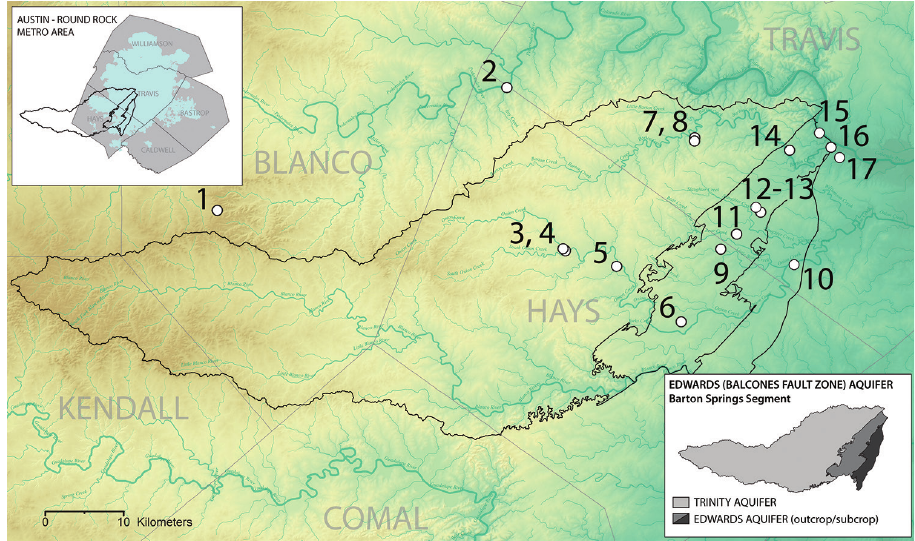
Figure 1. Sample Sites. Sampling map showing the extent of the Barton Springs Segment of the Edwards (Balcones Fault Zone) Aquifer and its hydrozones in Hays, Travis, and Blanco counties, Texas, USA. Sampling sites are numbered as follows: 1 Bamberger Ranch Spring 2 Red’s Spring 3 Emerald Spring 4 Bello Spring 5 Ben McCulloch Spring 6 Sky Ranch Tract - State Well No. 5857507 7